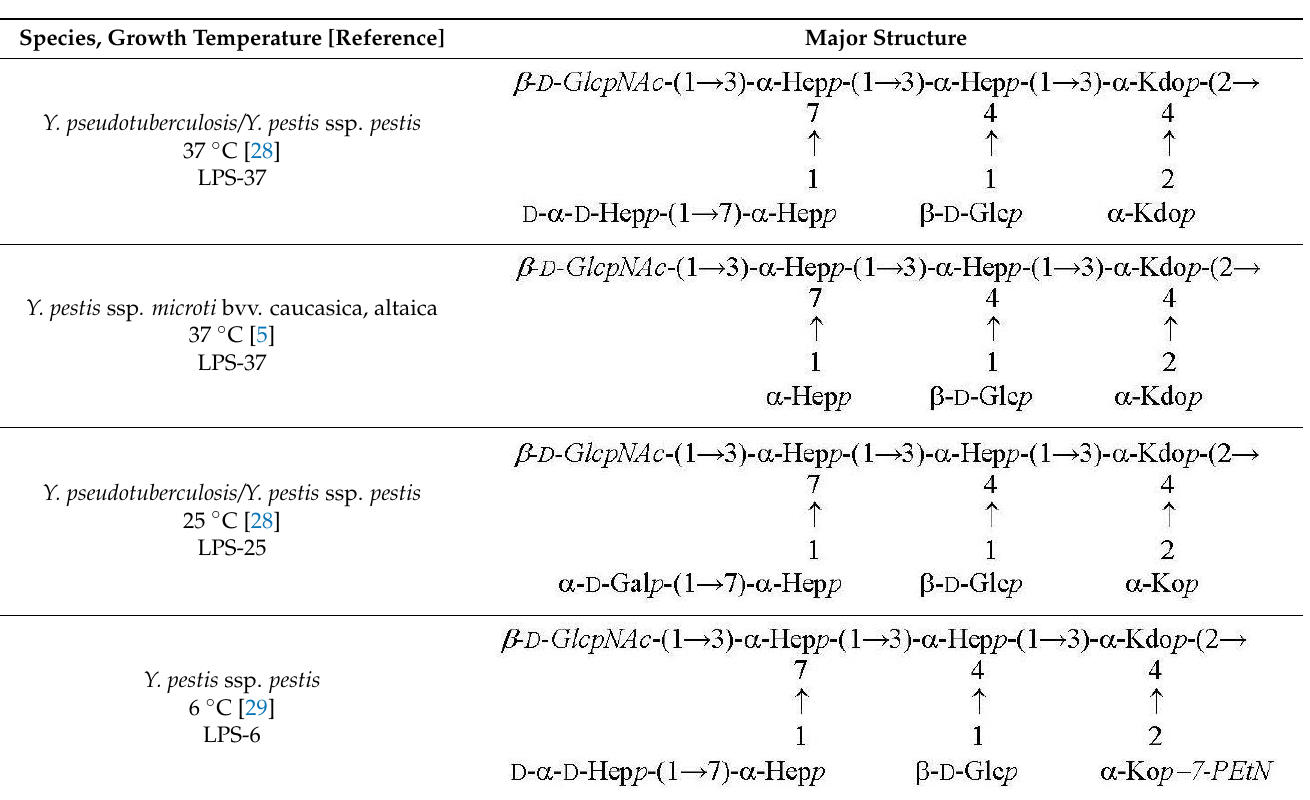
Table 2. Structures of the core oligosaccharides of Y. pseudotuberculosis/Y. pestis cultivated at various temperatures. Sub- stituents present in non-stoichiometric amounts are indicated in italics.